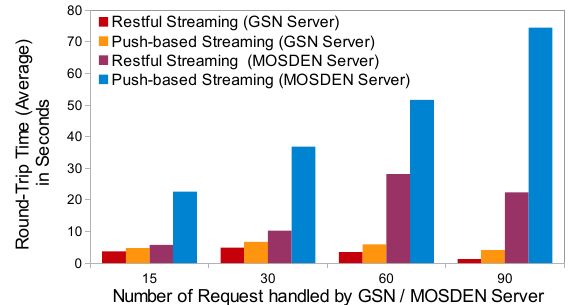
Figure 15. Comparison of Round-trip Times